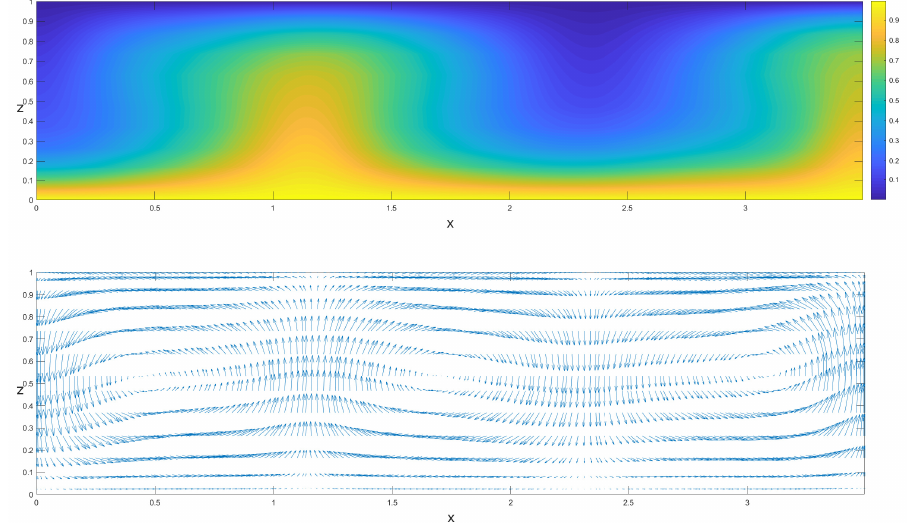
Figure 12. Isotherms and velocity field of a numerical solution obtained with alternating Schwarz domain decomposition; R = 10 4 , Γ = 3.495, np = 25, mp = 2, N × M = 12 ×